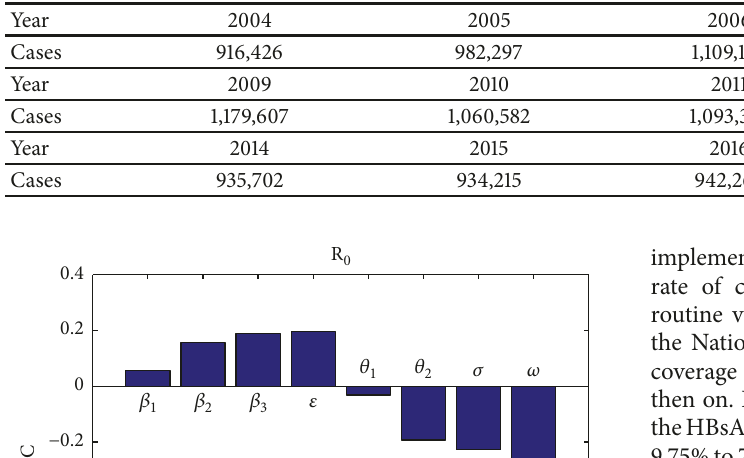
Table 2: Annually new reported HBV cases [23].